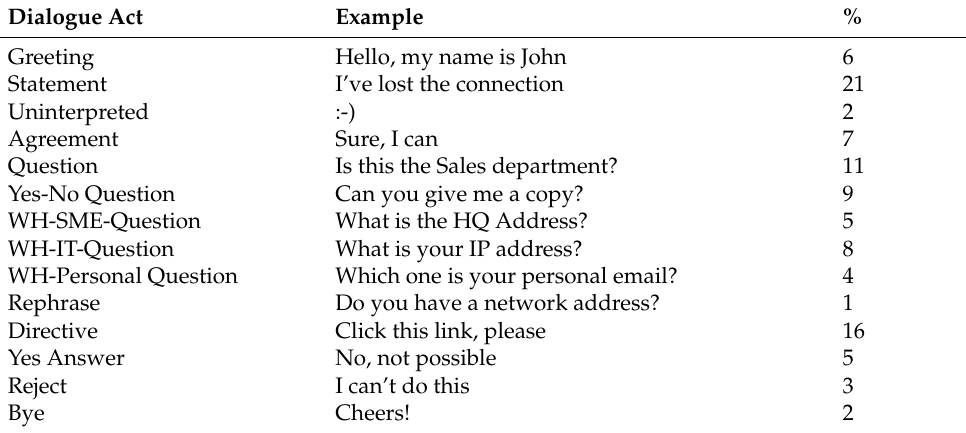
Table 3. Frequency of Dialogue Acts in SG-CSE Corpus.